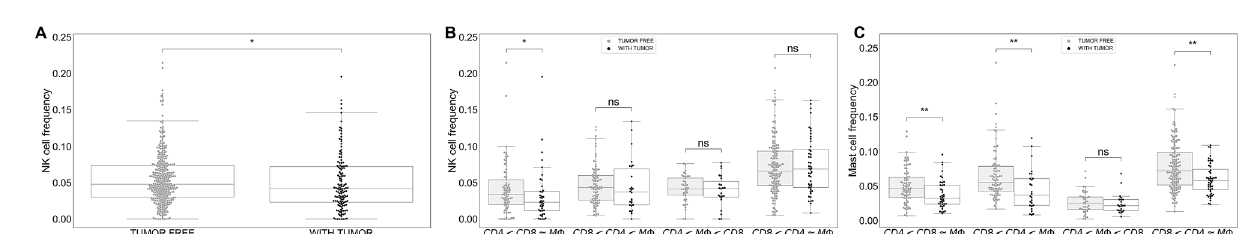
Figure 4. Frequency of NK cells and mast cells in ccRCC. Sub-figure ( A ) shows that patients who were tumor free at the last time of follow up have higher percentage of NK cells than patients with tumor at the last time. Sub-figures ( B ) and ( C ) respectively indicate the percentage of NK cells and mast cells in primary tumors in each